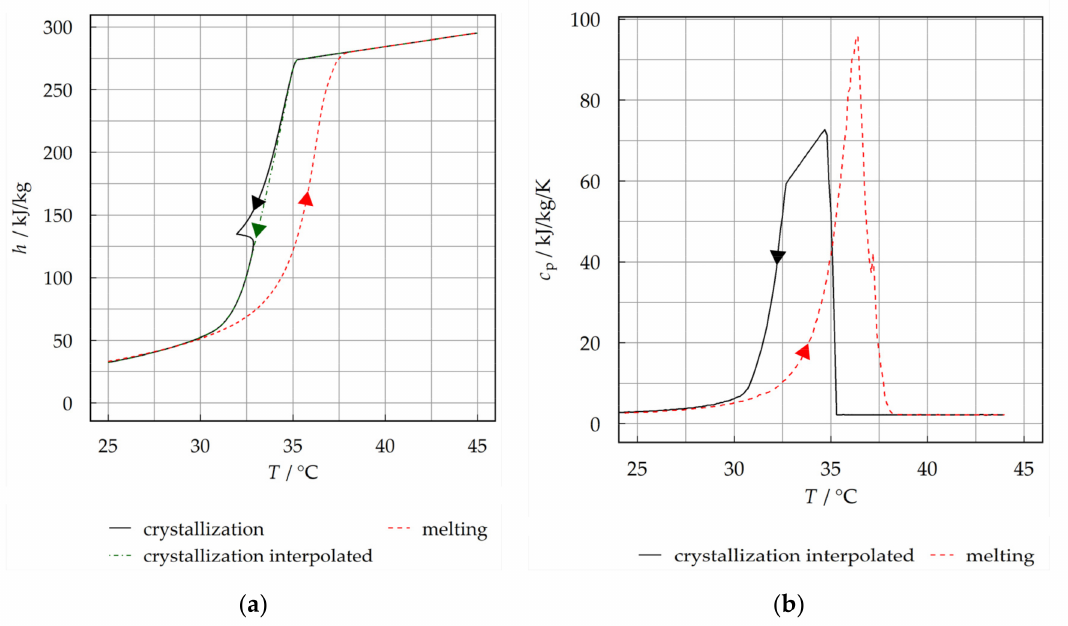
Figure 3. ( a ) Enthalpy temperature relation for crystallization, melting and the interpolated crystallization behavior; ( b ) Derived apparent heat